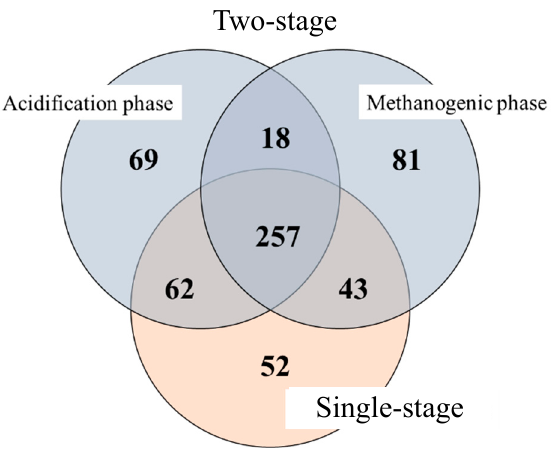
Figure 7. Venn diagram of core OTUs at static state period of two-stage and single-stage systems.